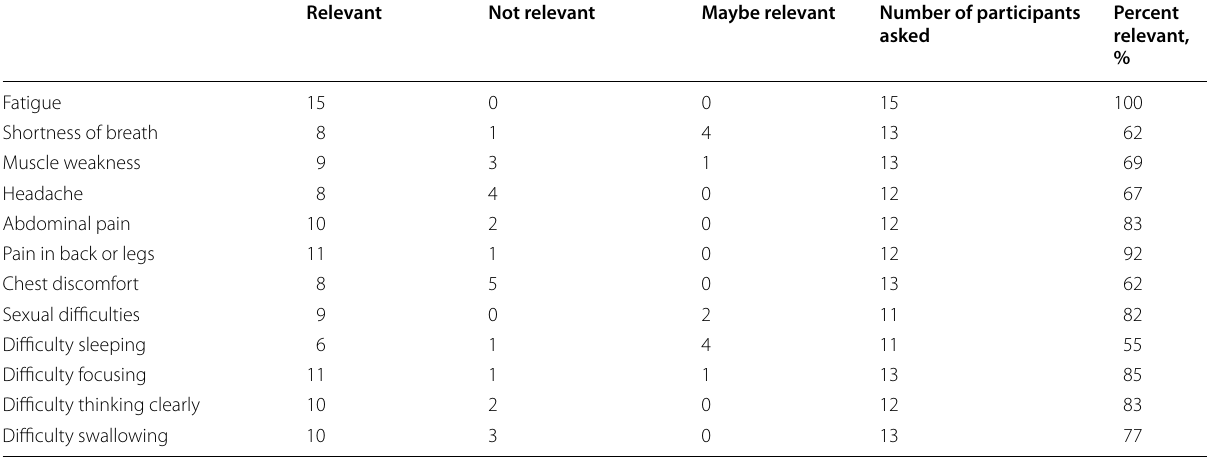
Table 4 Relevancy of items of the